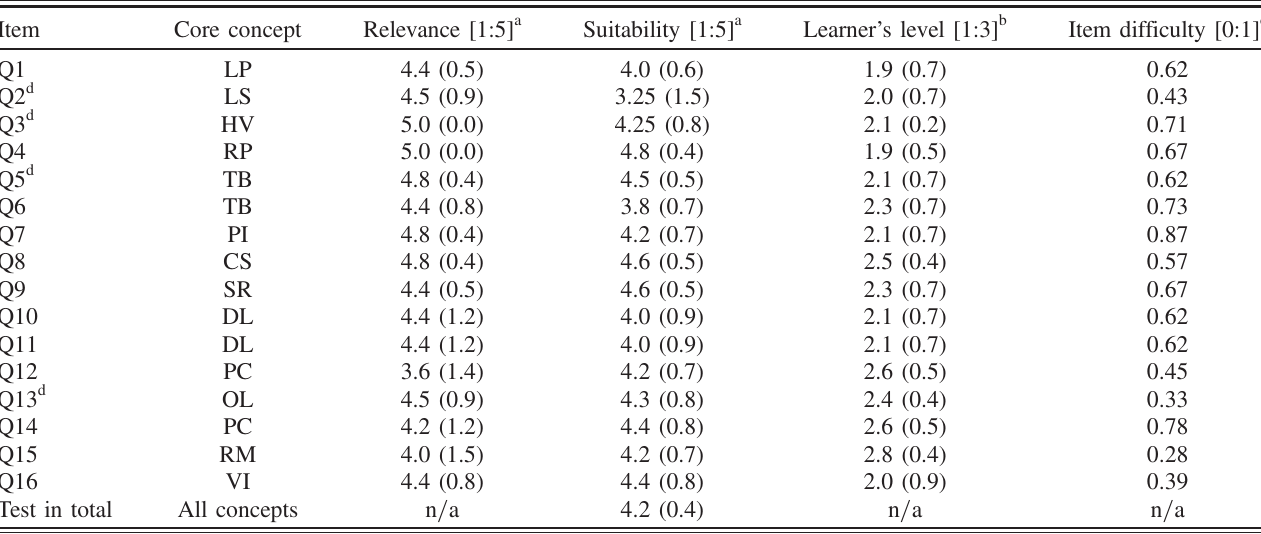
TABLE VIII. Means and standard deviations of the experts ’ ratings for the single items and for the test in total. Item difficulty was taken from the quantitative analyses and is displayed for easier comparison with the learner ’ s level.